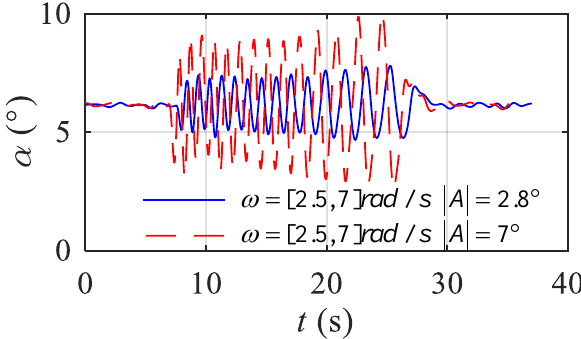
Figure 11. Angle of attack response under different amplitude excitation signals.